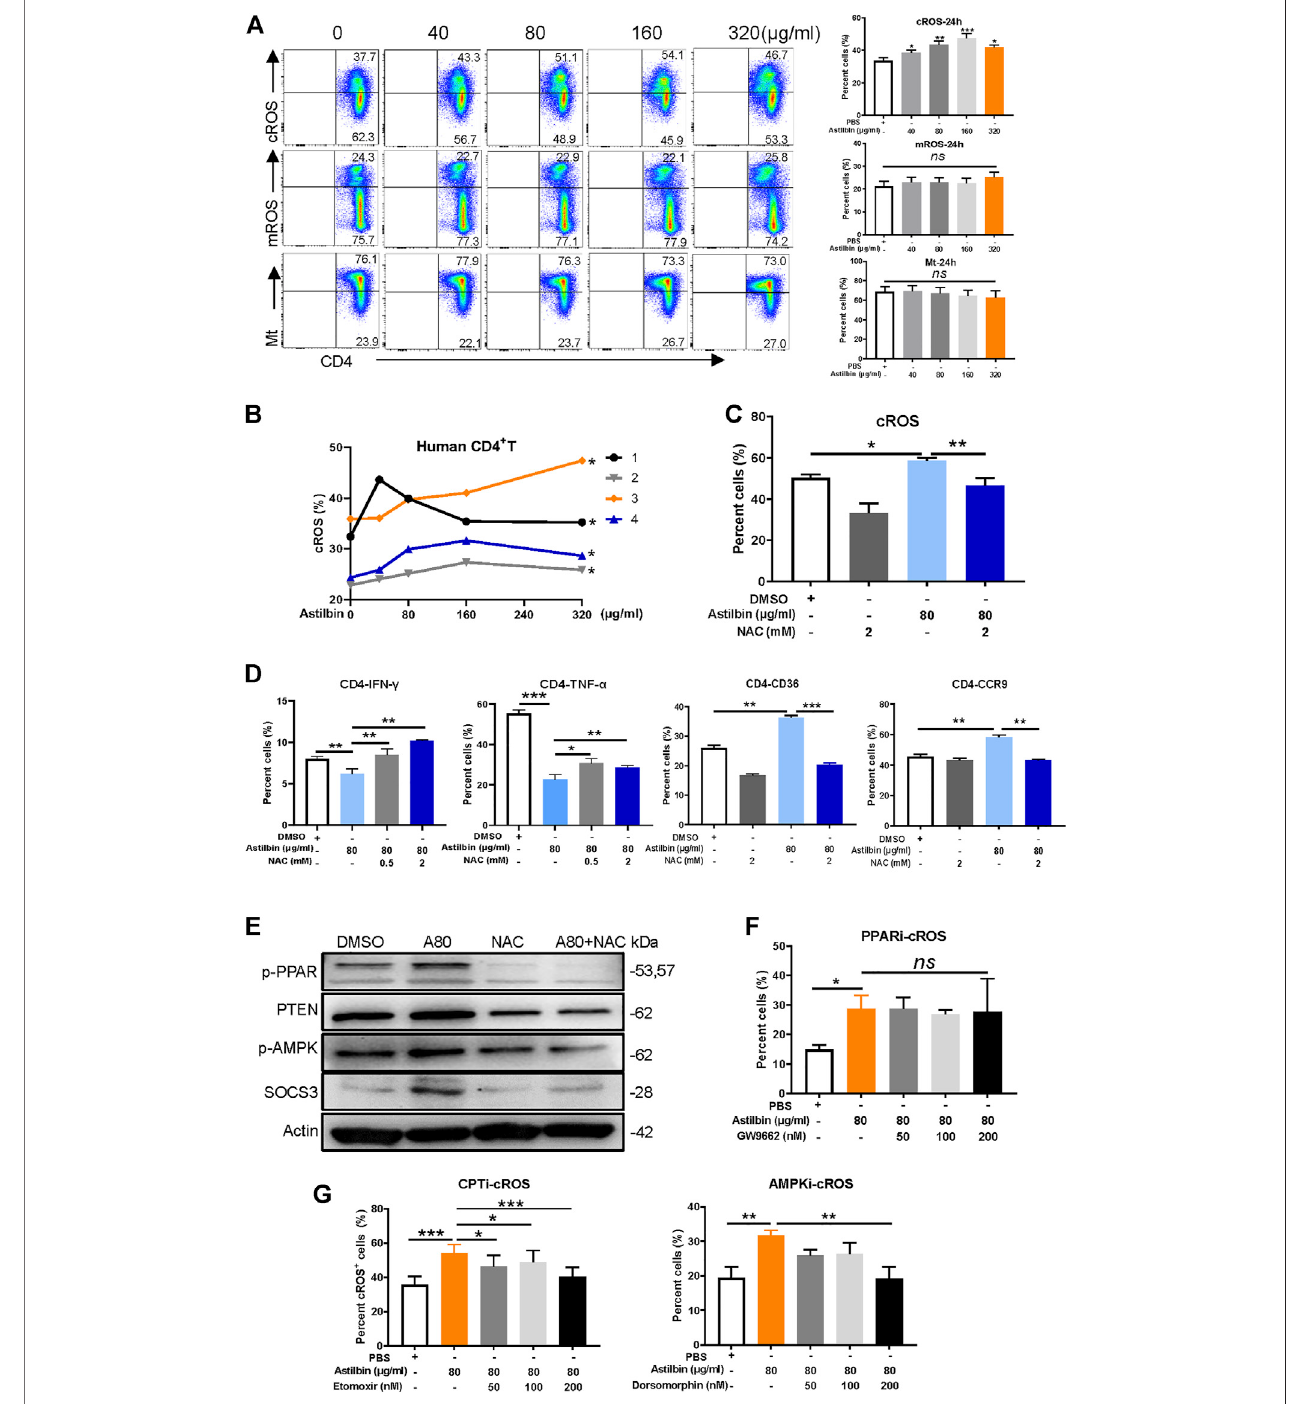
FIGURE 6 | cROS production induced by astilbin in CD4 + T cells. (A) Variations of cytoplasmic ROS, mROS, and mitochondrial weight in murine CD4 + T cells treated with astilbin for 24 h. Mean ± SD; n = 3. (B) Variations of cROS in human CD4 + T cells treated with astilbin. Mean ± SEM; n = 4. (C) Depletion of ROS by NAC (2 mM). Mean ± SD; n = 3. (D) Effects of ROS depletion on IFN- γ , TNF- α , CD36, and CCR9 of astilbin-treated CD4 + T cells. Mean ± SD; n = 3. (E) Effects of ROS depletiononp-PPAR γ ,PTEN,p-AMPK,andSOCS3ofastilbin-treatedCD4 + Tcells.EffectsofPPAR γ inhibition (F) andCPTorAMPKinhibition (G) oncellularROS production of astilbin-treated CD4 + T cells. Mean ± SD; n = 3. All experiments were conducted at least three times. p values (* p ≤ 0.05; ** p ≤ 0.01; *** p ≤ 0.001; ns, no signi fi cant difference) determined by one-way ANOVA (A,C,D,F,G) and two-way ANOVA (B) .